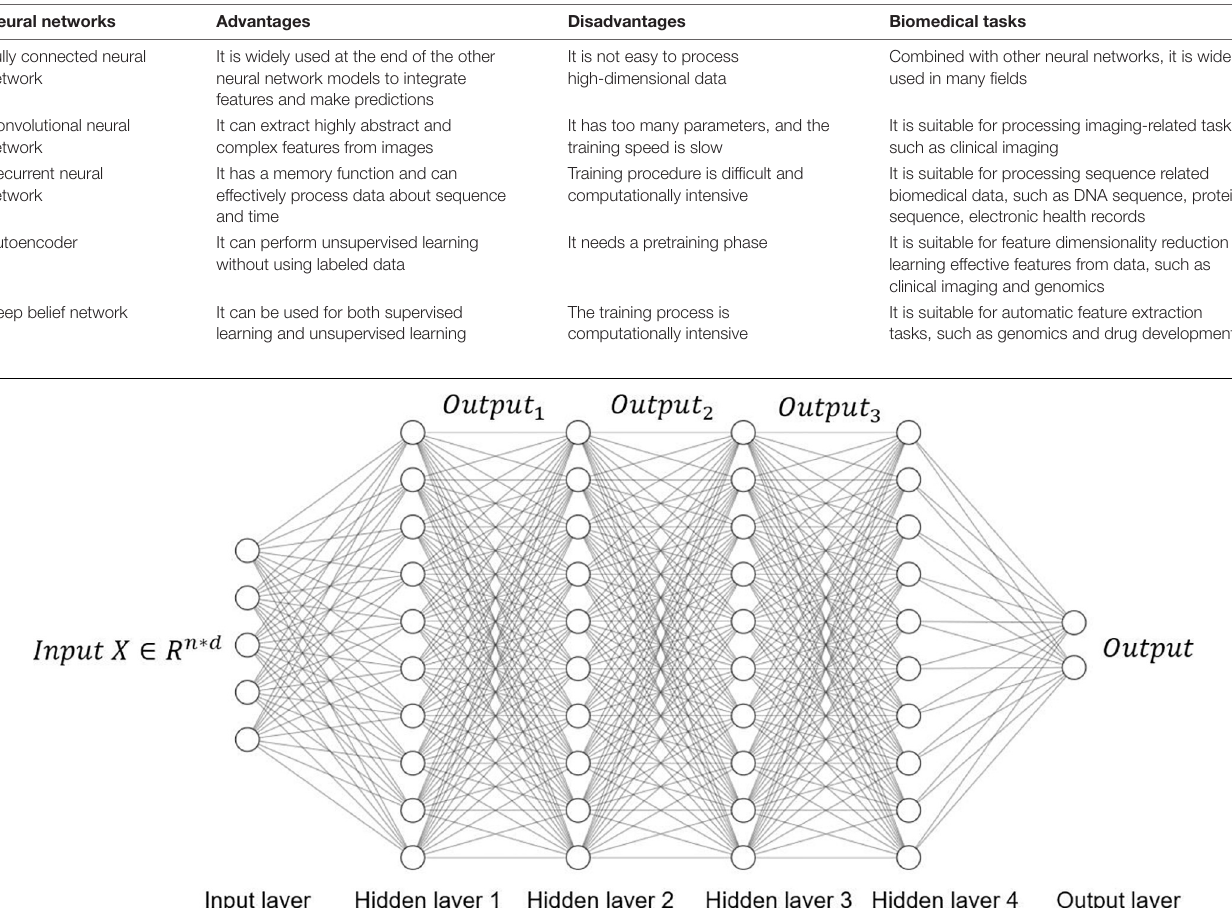
FIGURE 4 | Fully connected neural